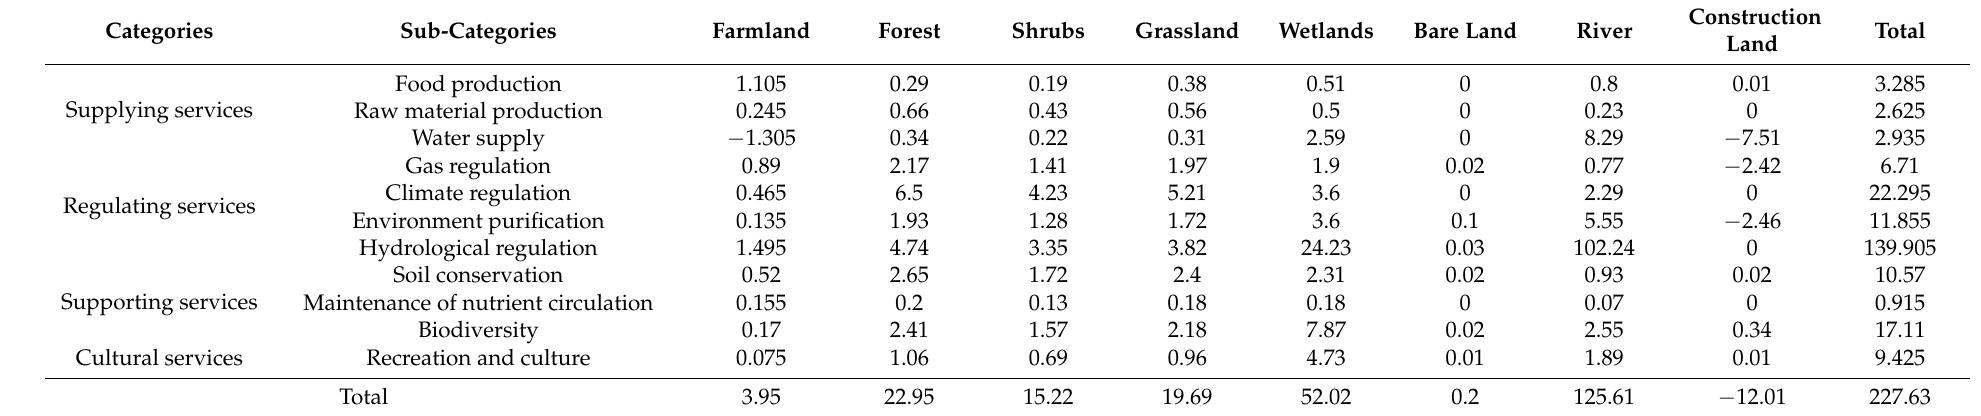
Table 3. Ecosystem service value equivalent per unit area of Hainan Province.